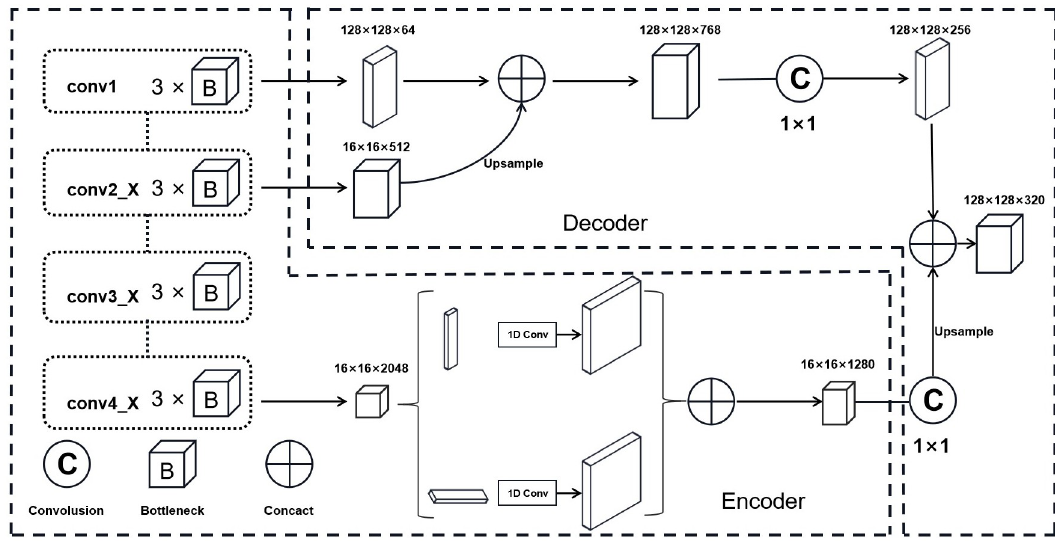
Fig 10. Improved encoder-decoder